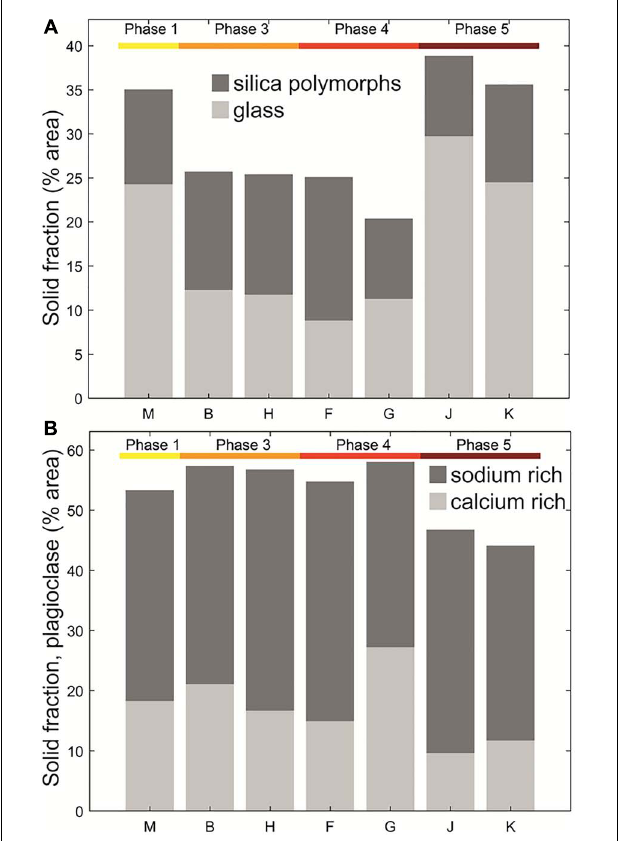
FIGURE 4 | Abundances of (A) glass and silica polymorphs, the remaining solid fraction is composed of the primary minerals (crystallinity, Table 2 ); (B) plagioclase – both sodium rich and calcium rich; shown as percentage area, calculated from 10 µ m resolution QEMSCAN images (shown in Figure 3 and Supplementary Figure S2 ), and Phase indicated by horizontal bars at the top of each